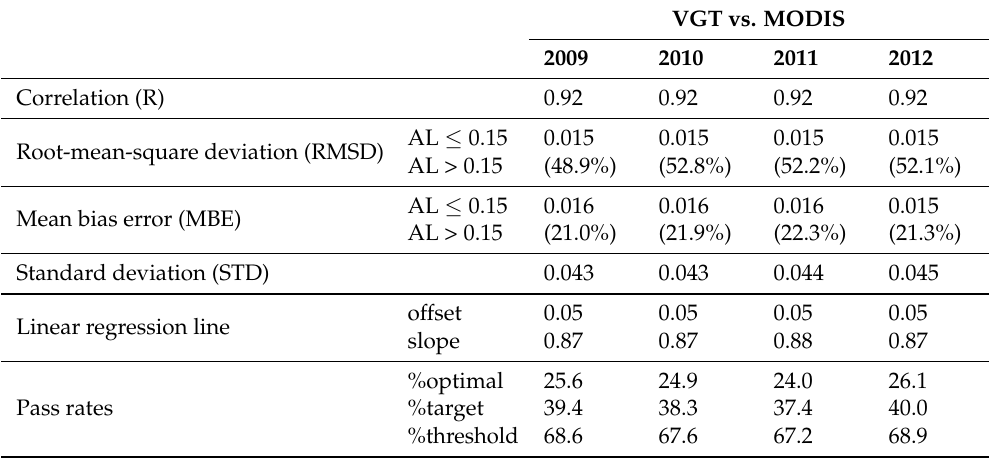
Table 10. Performance statistics between VGT versus MODIS products during the overlap period (2009–2012). Absolute MBE and RMSD are calculated over albedo values less 0.15 while relative MBE and RMSD (in %) are calculated over albedo values greater than 0.15.